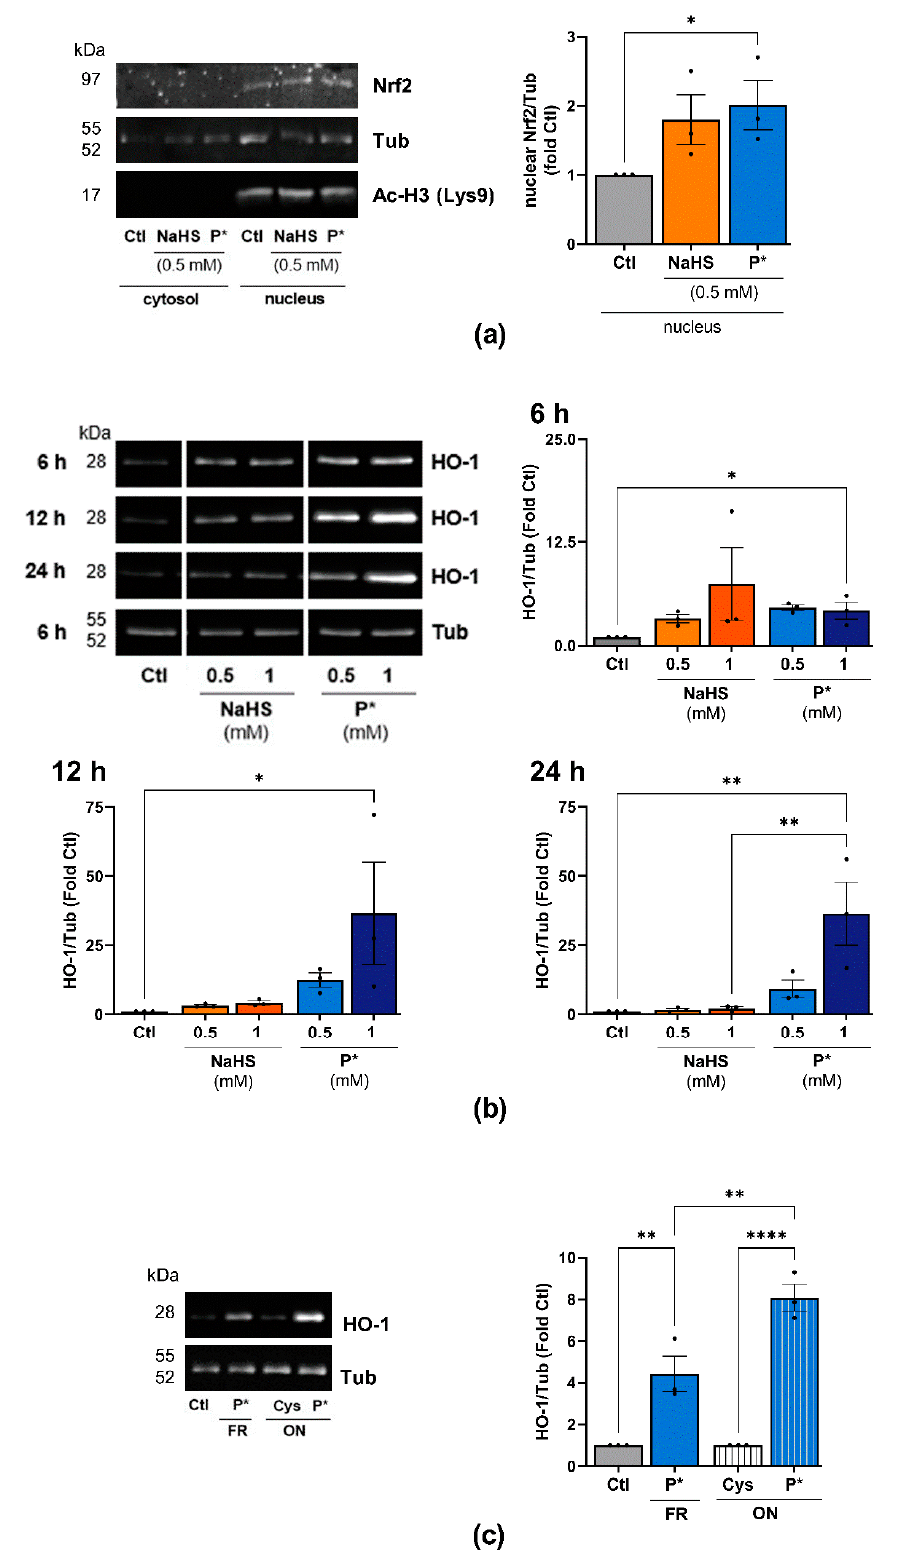
Figure 4. P* upregulates the Nrf2 pathway. ( a ) Western blot analysis of cytoplasmic and nuclear protein fractions in ATDC5 cells after 1 h of incubation with 0.5 mM NaHS or P*. Densitometry analysis values of Nrf2 (nuclear fraction) were normalized against α , β -tubulin (Tub) (nuclear frac- tion) and then compared with untreated cells (Ctl) set to 1, n = 3, * p < 0.05 (unpaired t -test). Acetyl-